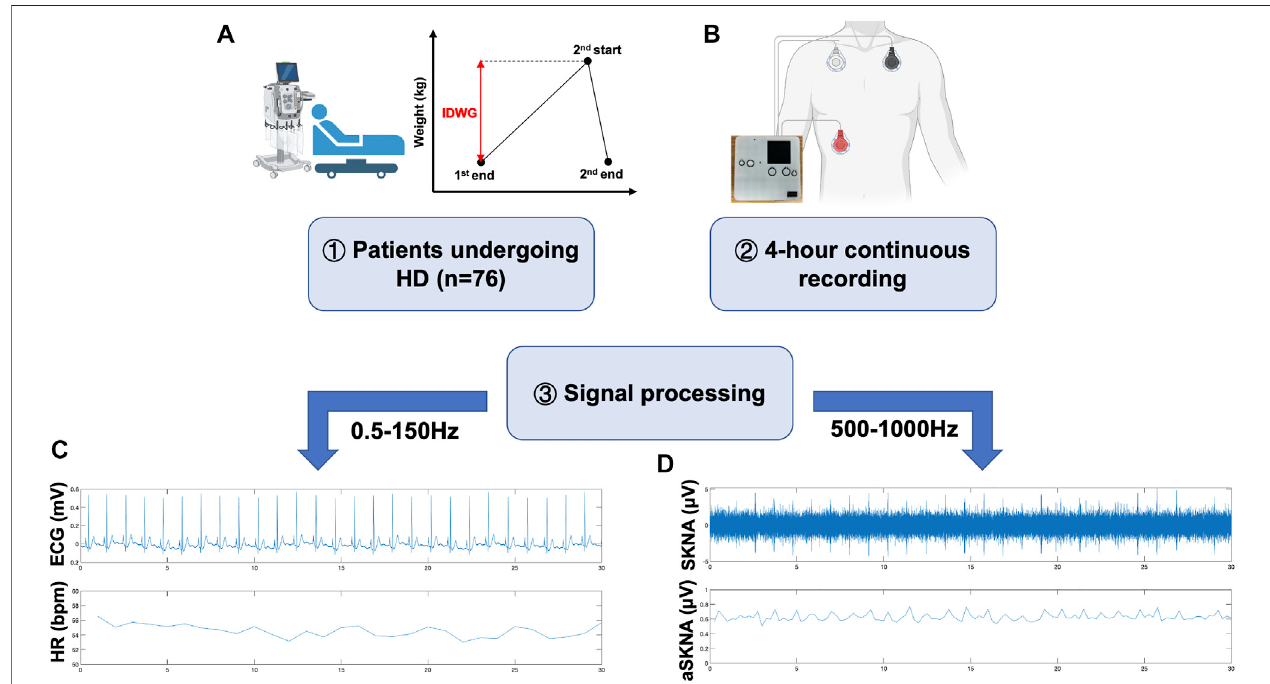
FIGURE 1 | Graphical illustration of this study. (A) 76 ESKD patients receiving MHD therapy were included in this study. IDWG refers to the fl uid accumulated between two times of HD as illustrated. (B) Home-made wearable devices were applied to record high-frequency signals for further analysis. Following previous protocols, electrode patches were placed in the left subclavicular area, right subclavicular area, and right abdomen. (C , D) Representative work fl ow of data processing. Rawdatawasapplied toa500 – 1000 Hzbandpass fi ltertogetSKNA (C) and 0.5 – 150 Hzbandpass fi ltertogetECG (D) .R-wavepeaks wereextracted forfurther HRV analysis using the PhysioNet